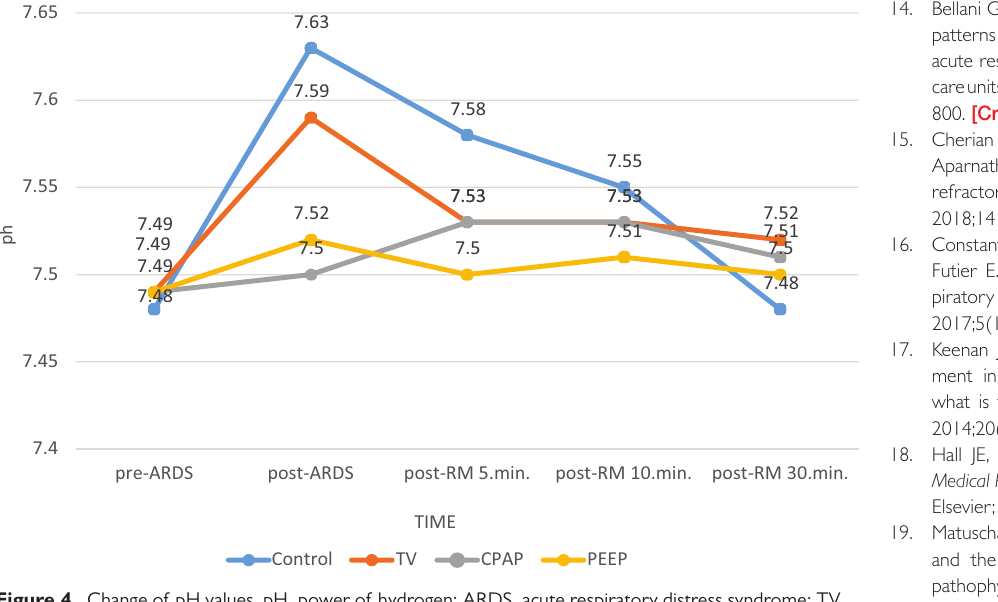
Figure 4. Change of pH values. pH, power of hydrogen; ARDS, acute respiratory distress syndrome; TV, tidal volume; CPAP, continuous positive airway pressure; PEEP, positive end-expiratory pressure;